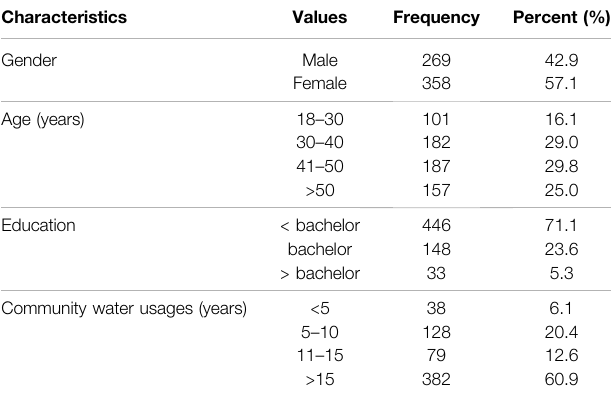
TABLE 1 | The demographic data of main testing respondents, Total ( N =